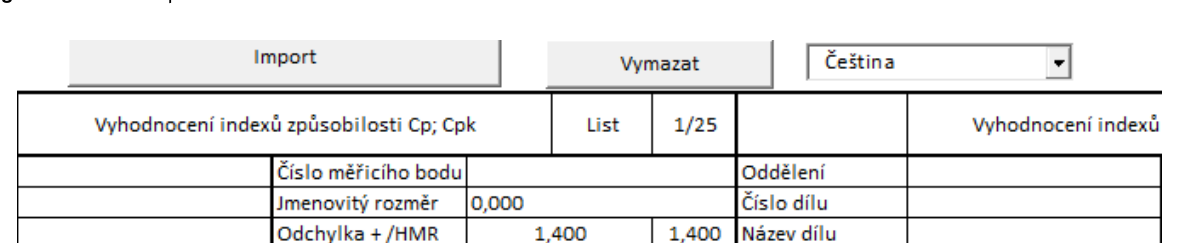
Figure 5: Calculation part of the form